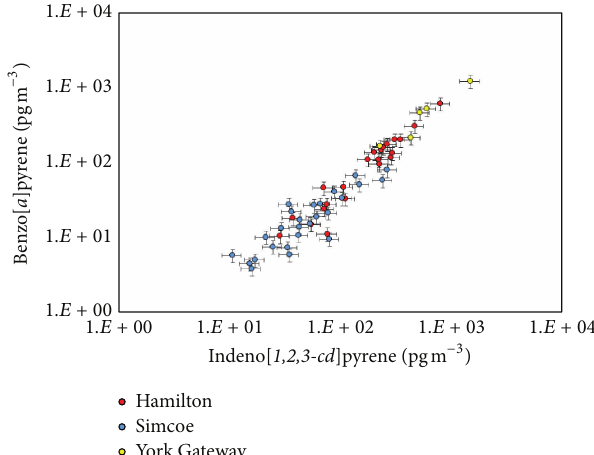
Figure 4: Log-log plot for benzo [𝑎] pyrene concentration as a function of indeno [1,2,3 - 𝑐𝑑] pyrene concentration observed at York Gateway tunnel (yellow), Hamilton (red), and Simcoe (light